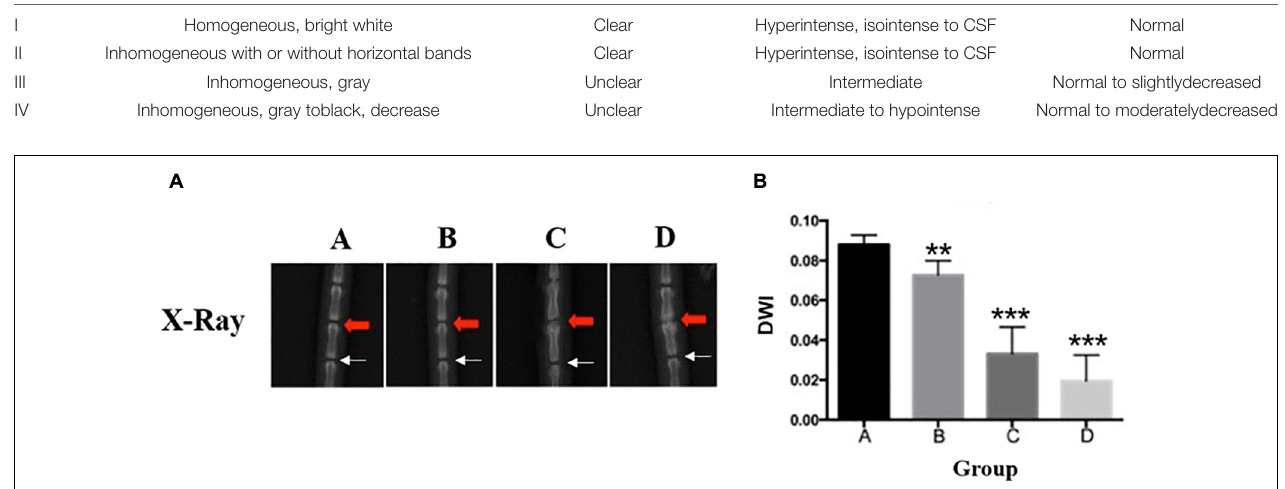
FIGURE 2 | (A) Representative radiographs of the tail were obtained before annulus needle puncture (ANP), 4 weeks after ANP, 8 weeks after ANP, and 12 weeks after ANP (red arrow: injured Co7/8, white arrow: uninjured Co8/9). No degeneration was observed in the adjacent disks (white arrow). (B) The disc height index (DHI) progressively decreased over time. %DHI post hoc test demonstrated a statistically significant difference in DHI between pre- and post-puncture (each of the subsequent weekly measurements). **, significant difference from other group disks ( p ≤ 0.01); ***, significant difference from other groups ( p ≤ 0.001).